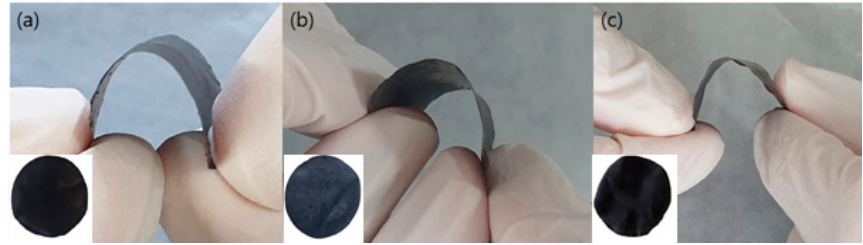
Figure 1. Images of the ( a ) LC40, ( b ) LC50, and ( c ) LC60